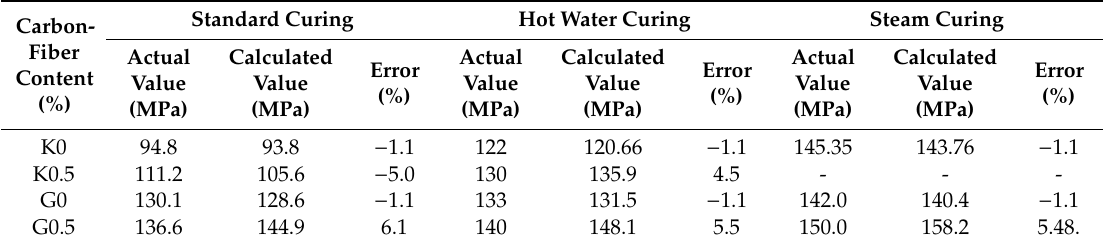
Table 10. RPC compressive strength from References [27,28].